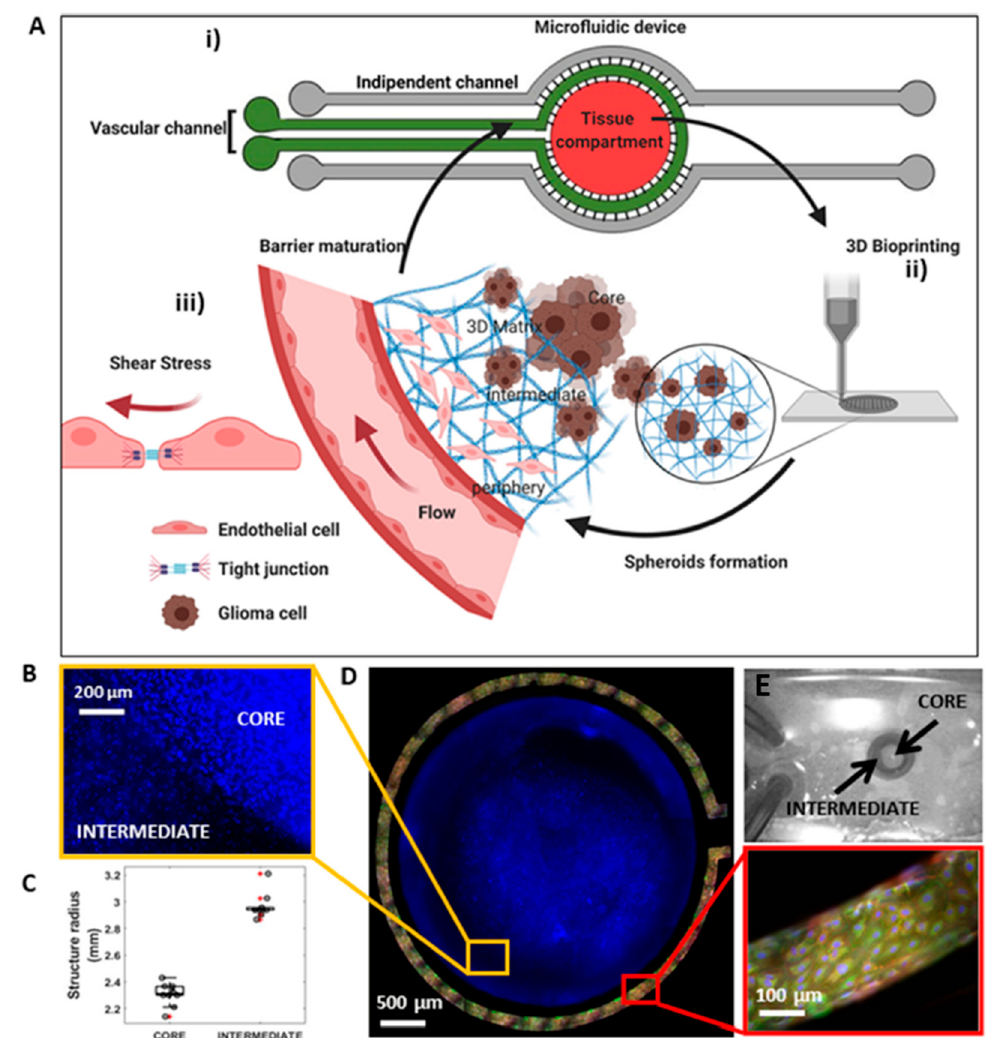
Figure 4. Three-dimensional bioprinted vascularized glioblastoma-on-a-chip. ( A ) Schematic of (i) the microfluidic device, (ii) the bioprinting process and (iii) the flow alongside the embedded tissue. ( B ) Intermediate and core interface ( C ) Scatter data points for structure’s radius. ( D ) Fluorescent images of bioprinted tissue and vascular vessel. ( E ) Photograph of the glioblastoma-on-a-chip. Reprinted with permission granted by Copyright Clearance Center, Inc. (“CCC”). Published in Advanced Therapeutics by Wiley-VCH GmbH, Vol 4, by G. Silvani et al., “3D-Bioprinted Vascularized Glioblastoma-on-a-Chip for Studying the Impact of Simulated Microgravity as a Novel Pre-Clinical Approach in Brain Tumor Therapy”, Figure 1 [74].